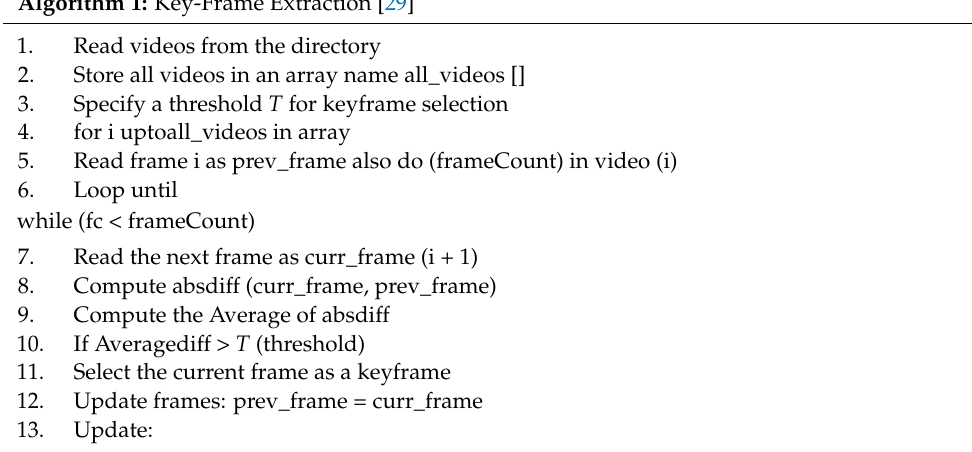
Algorithm 1: Key-Frame Extraction